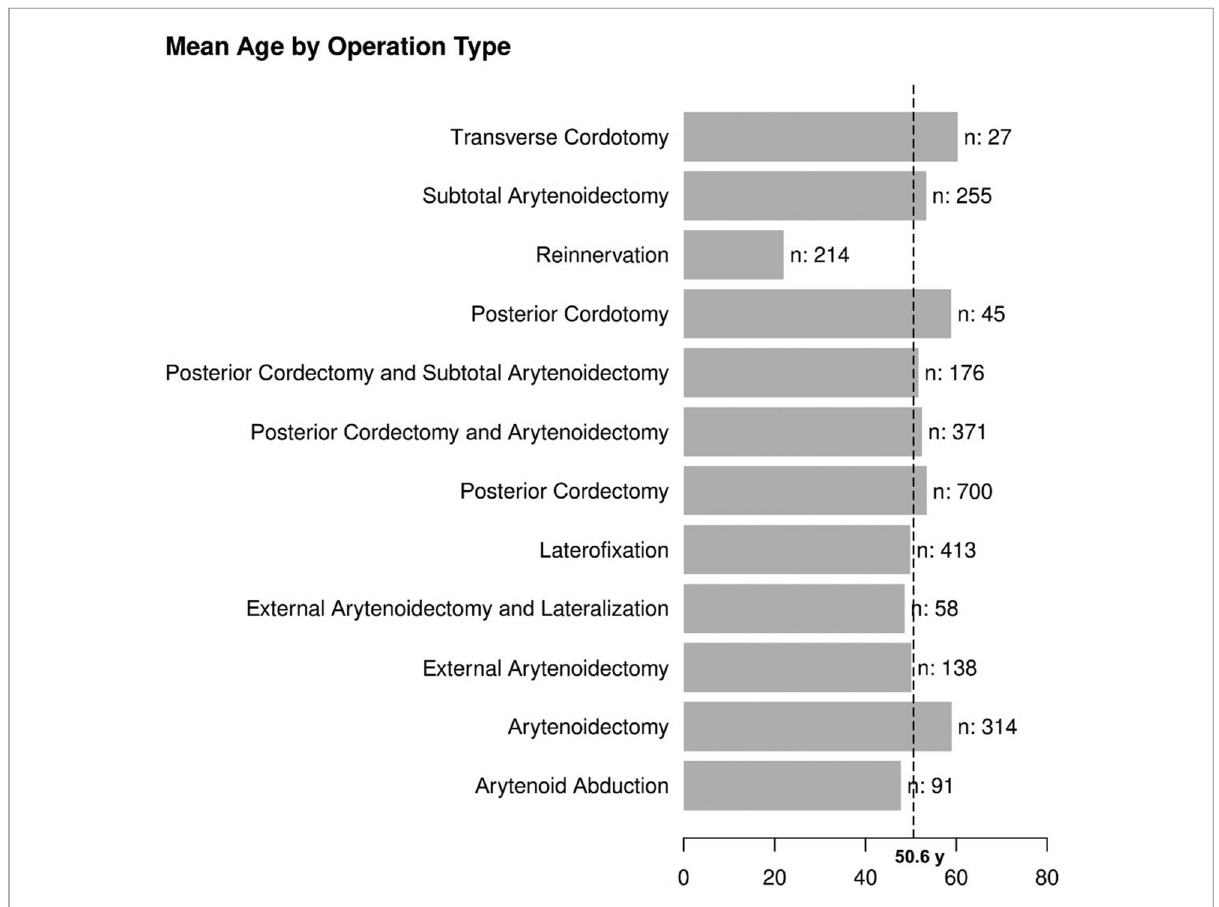
FIGURE 1 Mean age in years (y) of the patient in relation to chosen surgical technique. Dotted line shows weighted mean weight (total number of patients in